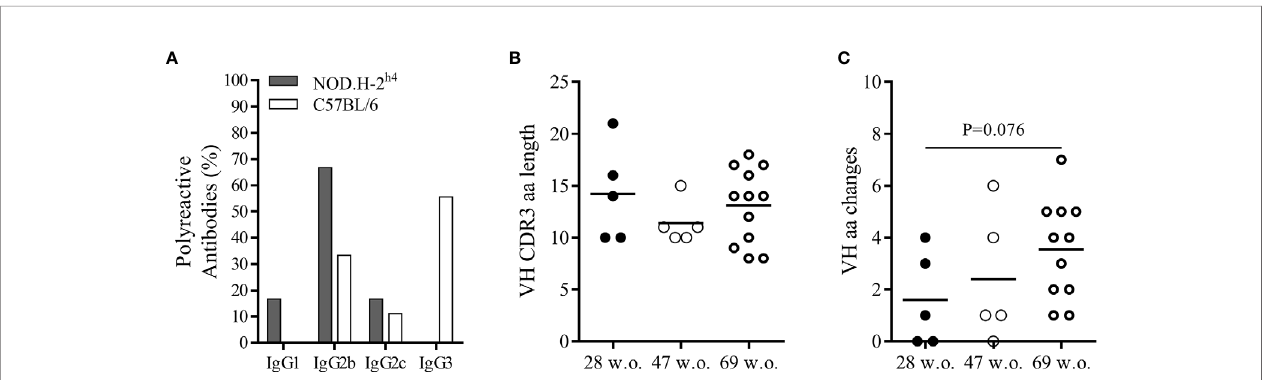
FIGURE 5 | Mutational analysis and IgG subclass differences between polyreactive antibodies of NOD.H-2 h4 and C57BL/6J. Frequency of polyreactive IgG subclasses in NOD.H-2 h4 and C57BL/6J mice (A) . Data are pooled from independent experiments for NOD.H-2 h4 and C57BL/6J mice. CDRH3 amino acid length (B) and number of VH replacing mutations (C) are shown. Data are pooled from independent experiments for each NOD.H-2 h4 and C57BL/6J mice age. P-values were calculated by unpaired t